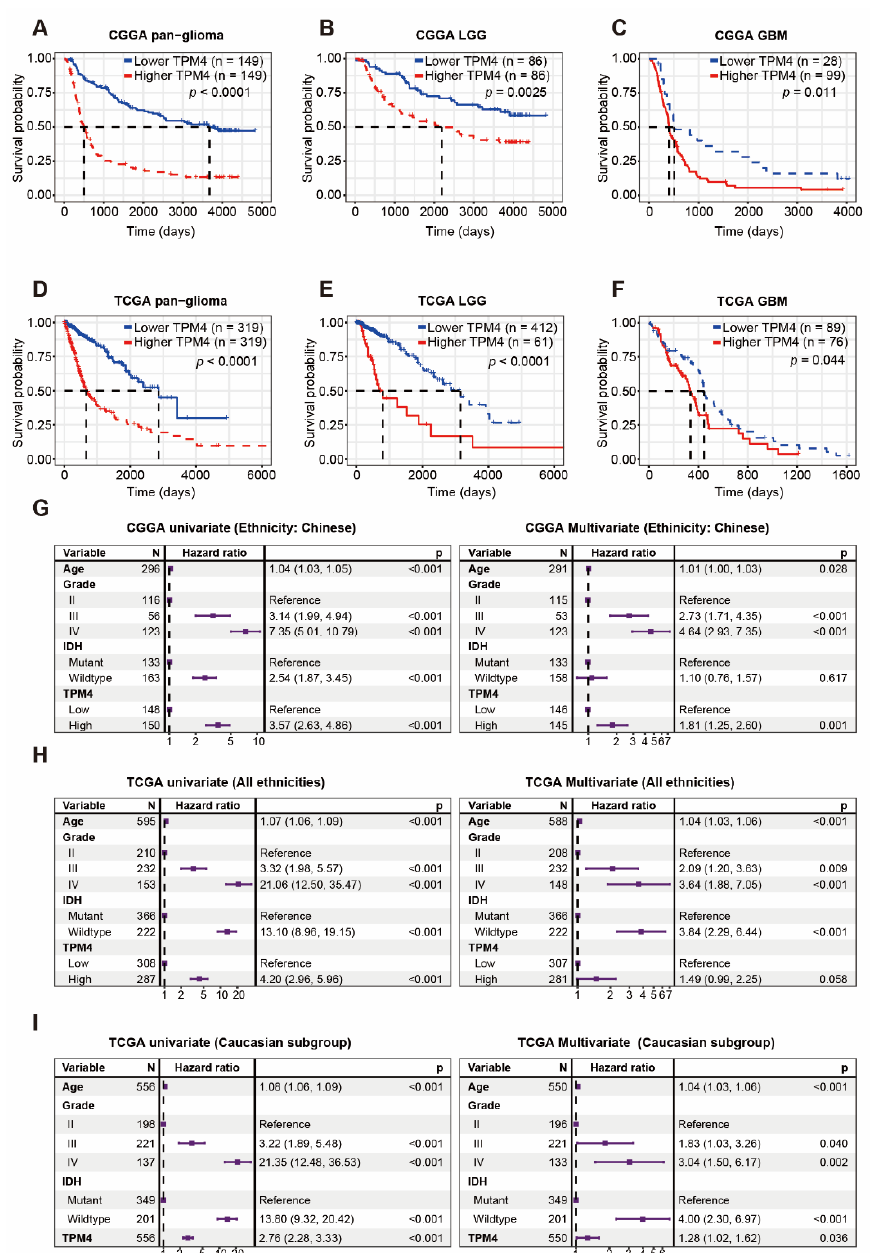
Figure 7. Prognostic value of TPM4 in glioma. ( A – C ) Kaplan–Meier survival analysis according to TPM4 in CGGA microarray dataset. ( D – F ) Kaplan–Meier survival analysis according to TPM4 in TCGA RNAseq dataset. ( G ) Univariate and multivariate Cox regression model in CGGA microarray dataset (ethnicity: Chinese). ( H ) Univariate and multivariate Cox regression model in TCGA RNAseq dataset (all ethnicities). ( I ) Univariate and multivariate Cox regression model in TCGA RNAseq dataset (Caucasian subgroup).